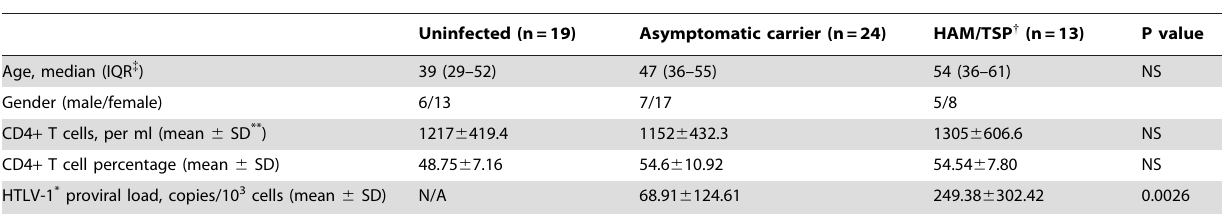
Table 1. Characteristics of study